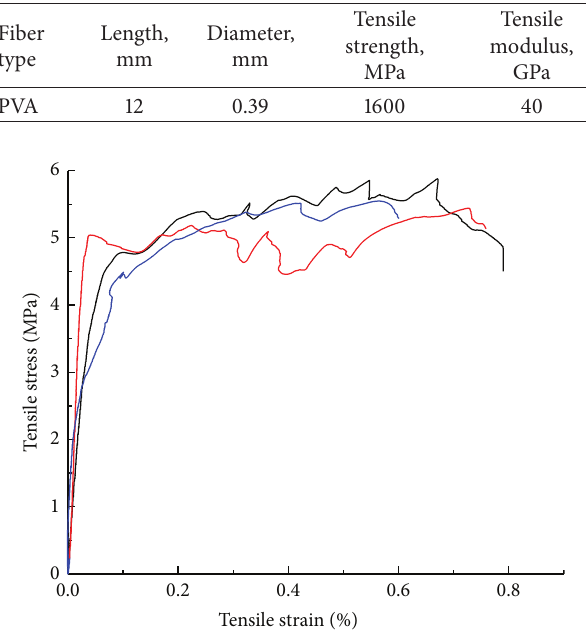
Figure 1: Stress-strain curves of uniaxial tensile